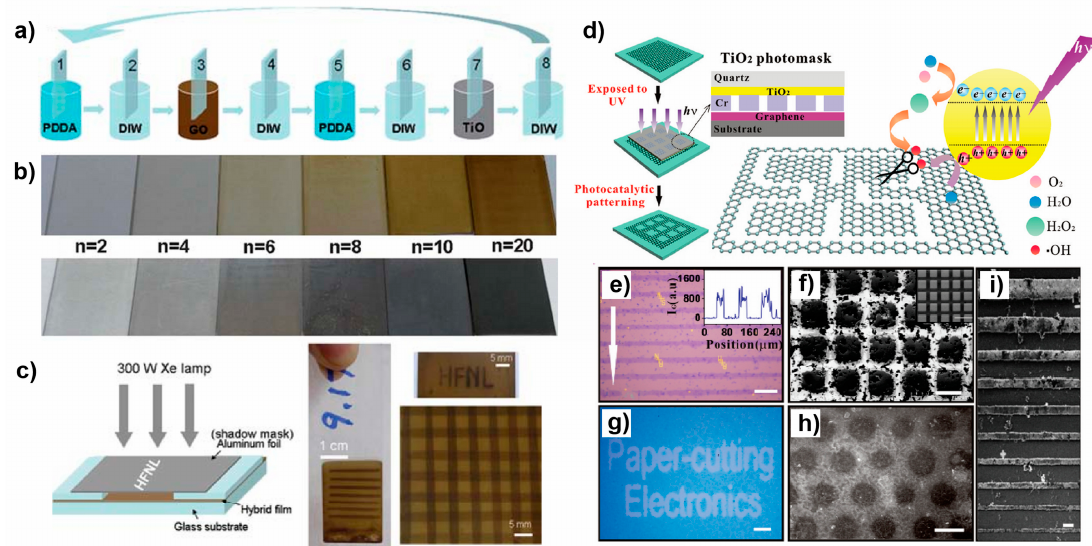
Figure 8. Photocatalytic patterning of graphene. ( a ) Schematic illustration of the fabrication procedure of layer-by-layer hybrid films consisting of PDDA/GO/PDDA/TiO x . ( b ) Photographs of (PDDA/GO/PDDA/TiO x ) n hybrid films with different layers, before and after illumination with a 300 W Xe lamp for 30 min. ( c ) Model setup for the photocatalytic reduction lithography (PRL) approach and the corresponding PRL patterns on the (PDDA/GO/PDDA/TiO x ) 20 hybrid film after illumination. Reproduced by permission of The Royal Society of Chemistry from ref. [54]. ( d ) Schematic illustration of the photocatalytic approach to engineering single- or few-layer graphene. ( e , g ) Optical and ( f–i ) SEM images of patterned reduced graphene oxide (RGO) illustrating the feasibility of complex structural design. Scale bars: ( e–h ) 50 µ m, inset of ( e ) 100 µ m, ( i ) 10 µ m. Reproduced with permission from [55], American Chemical Society, 2011.